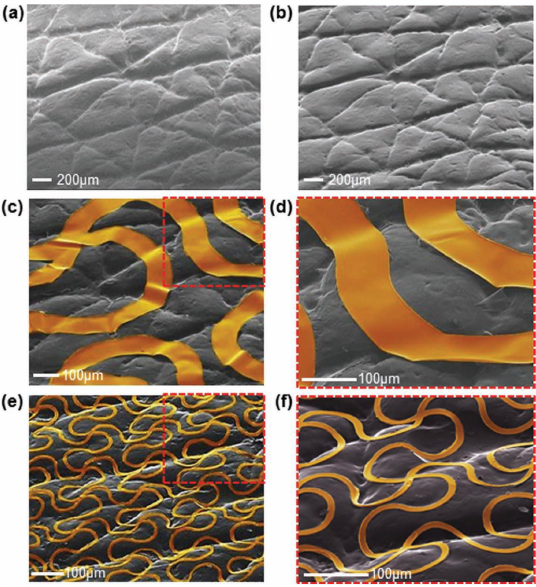
Figure 4. ( a ) Epidermal electronic system (EES) made of a skin replica created from the forearm, before and; ( b ) after application of a spray-on-bandage; ( c ) Colourized microscopy image of the EES with conductive gold films of 100 µ m and; ( e ) its magnified view. ( d ) Microscopy image of EES with gold films of 10 µ m and; ( f ) its magnified view